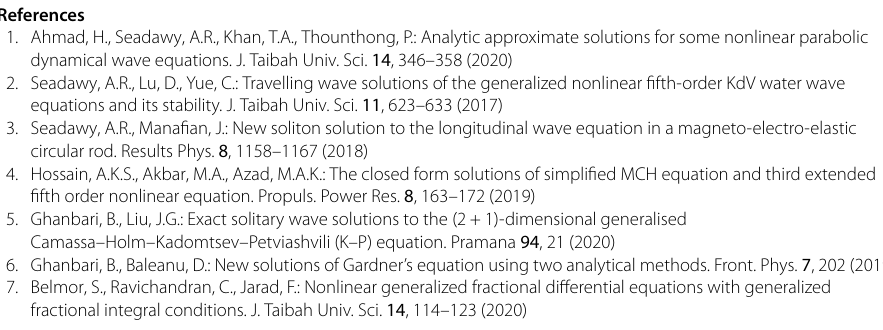
procedure fully approved the dependability of our computational work and could be im- plemented to study other physical